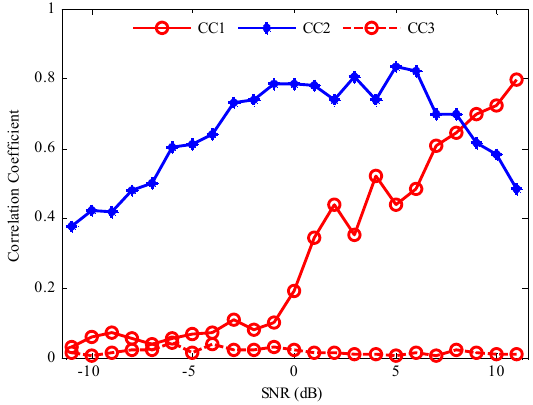
Figure 3. The correlation coefficients between x ( t ) and their corresponding PF components.